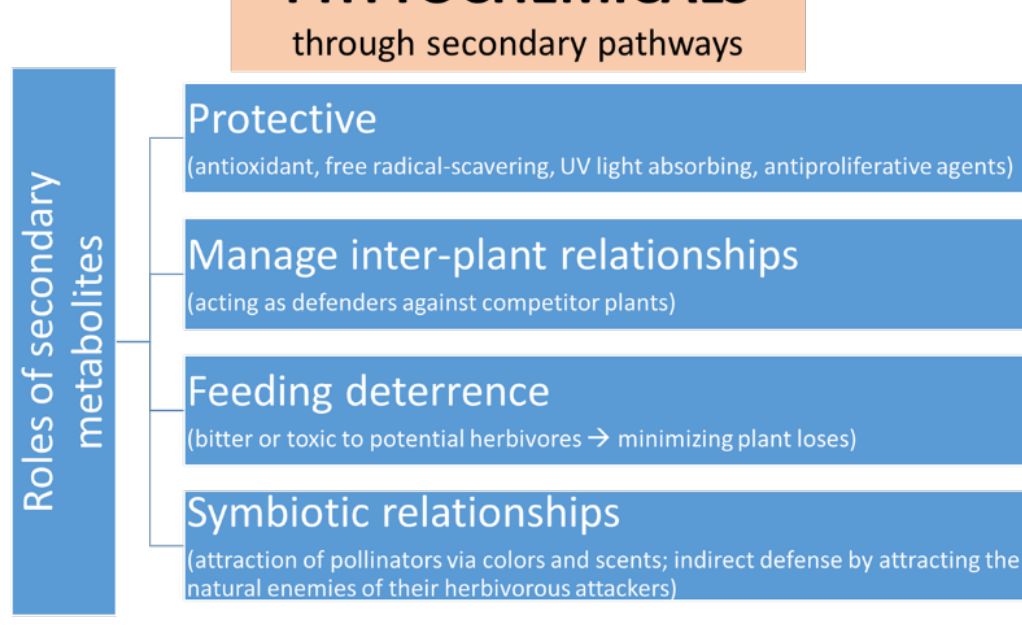
Figure 1. Phytochemicals and their role in plants.